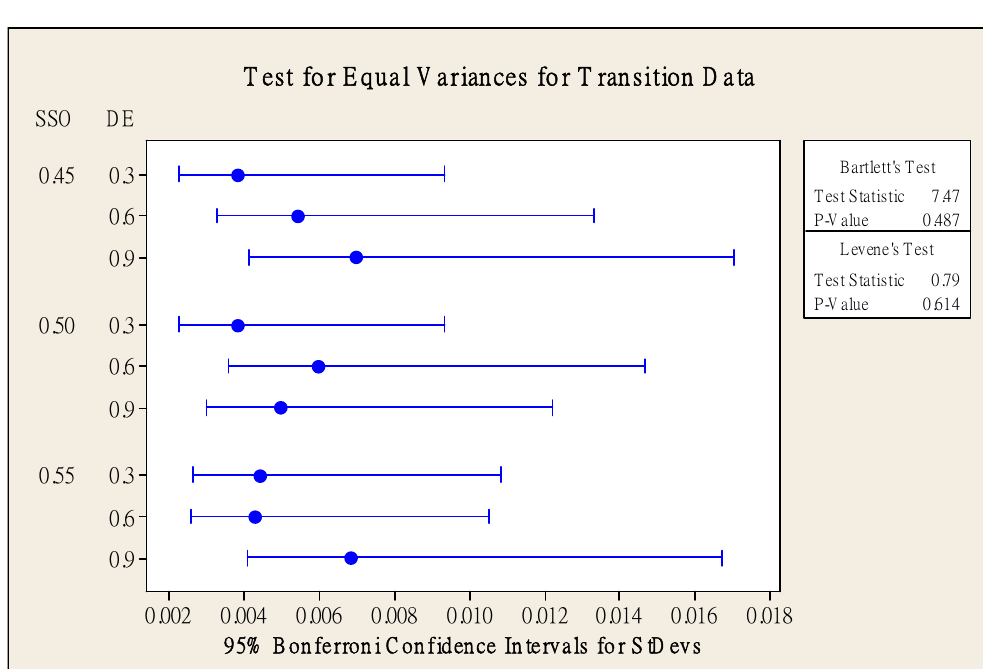
Figure 3. Homogeneity test for spring (autumn).